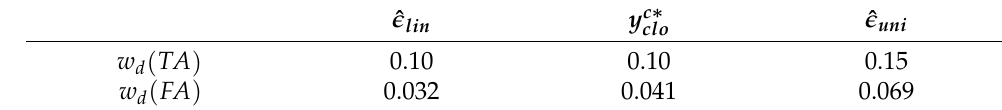
Table 4. Medians of the Wasserstein metric w d to the observed relative samples y c ∗ validation points.